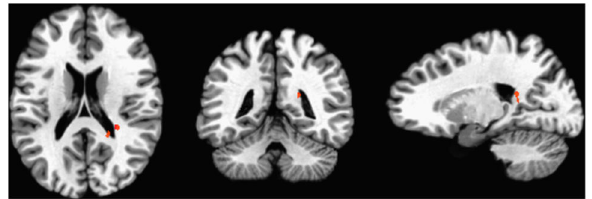
Figure 3. Caudate activity greater in MS group relative